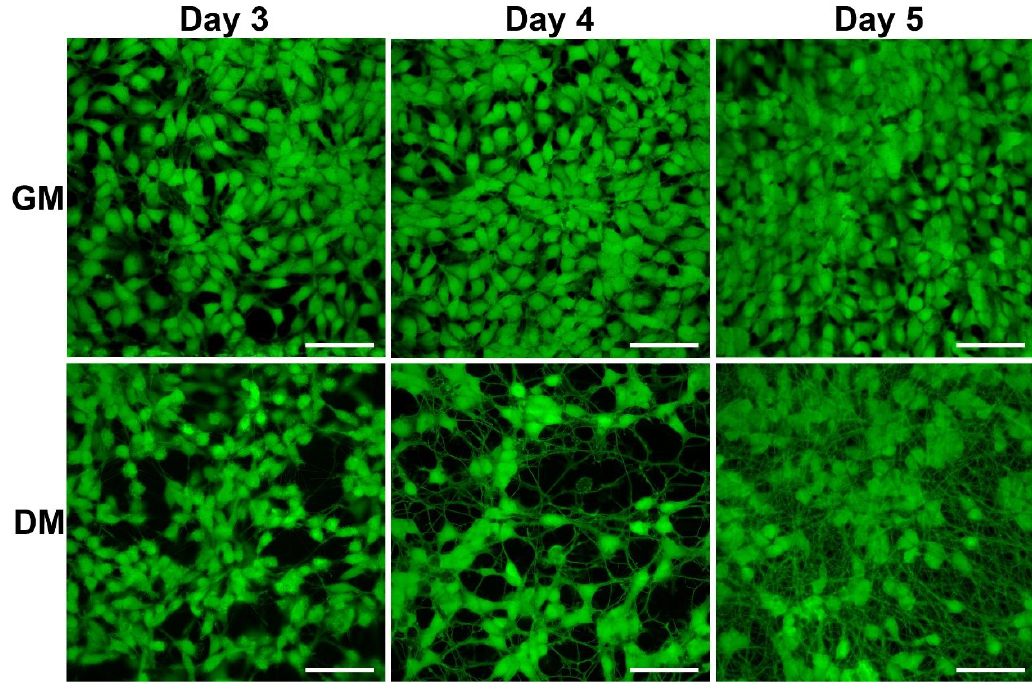
Figure 3. Fluorescence microscopy images of live stained (Calcein AM) LUHMES cells in growth medium (GM) and differentiation medium (DM). Initial cell density 60,000 cells/cm 2 . Time in days after cell seeding. (Scale bars: 50